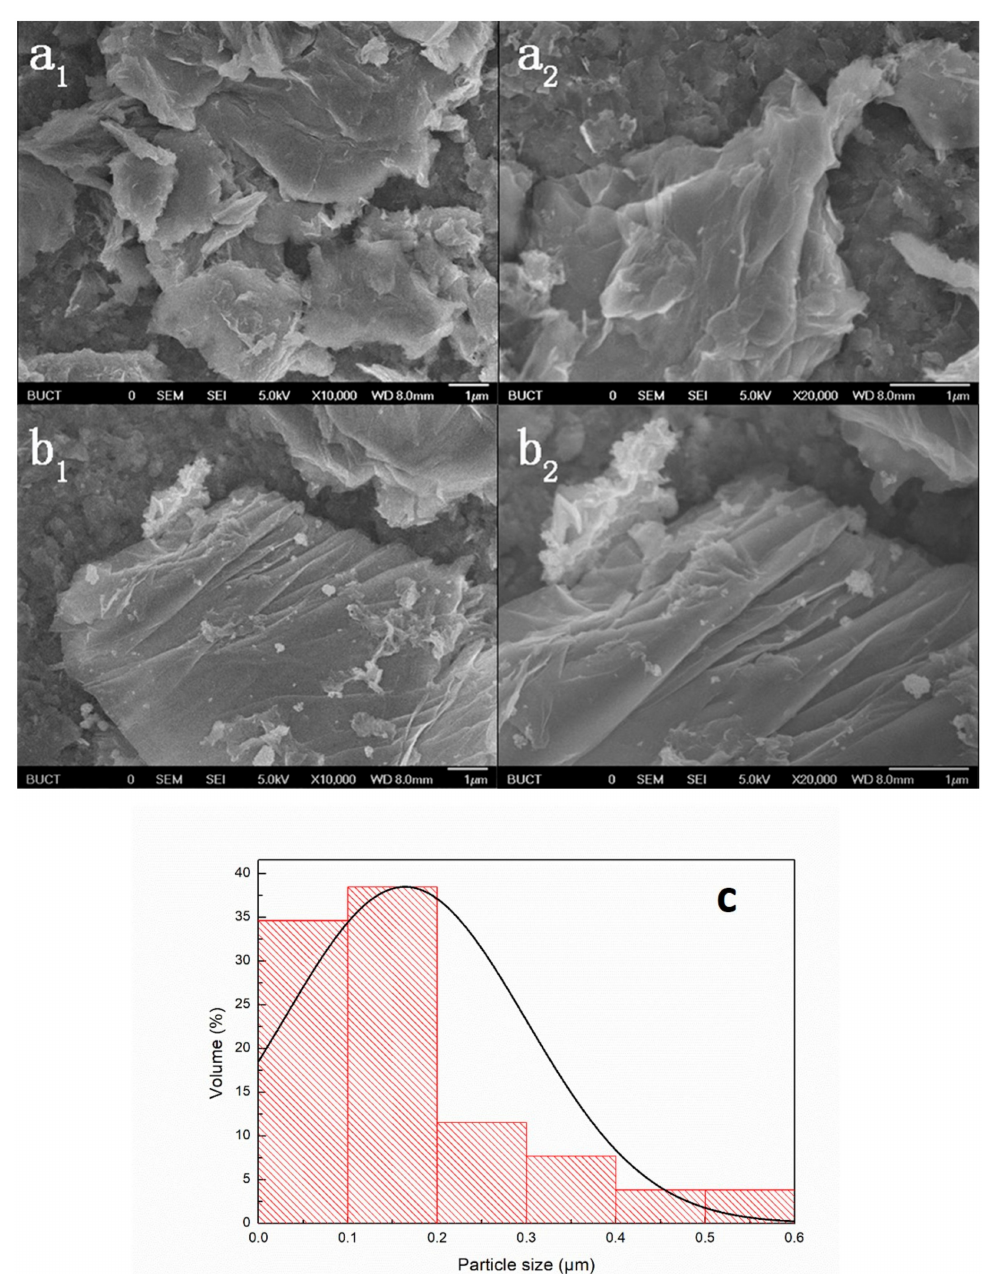
Figure 5. SEM image ( a 1 , a 2 ) GO, ( b 1 , b 2 ) TiO 2 –GO, and ( c ) The particle size distribution of b 1